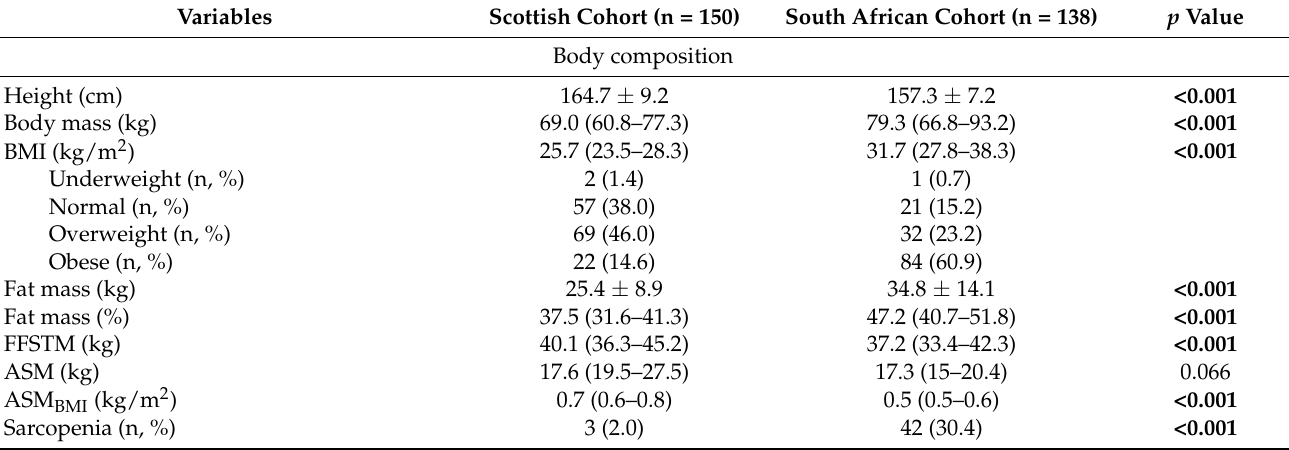
Table 2. Body composition, and functional and musculoskeletal variables of Scottish and South African cohorts.